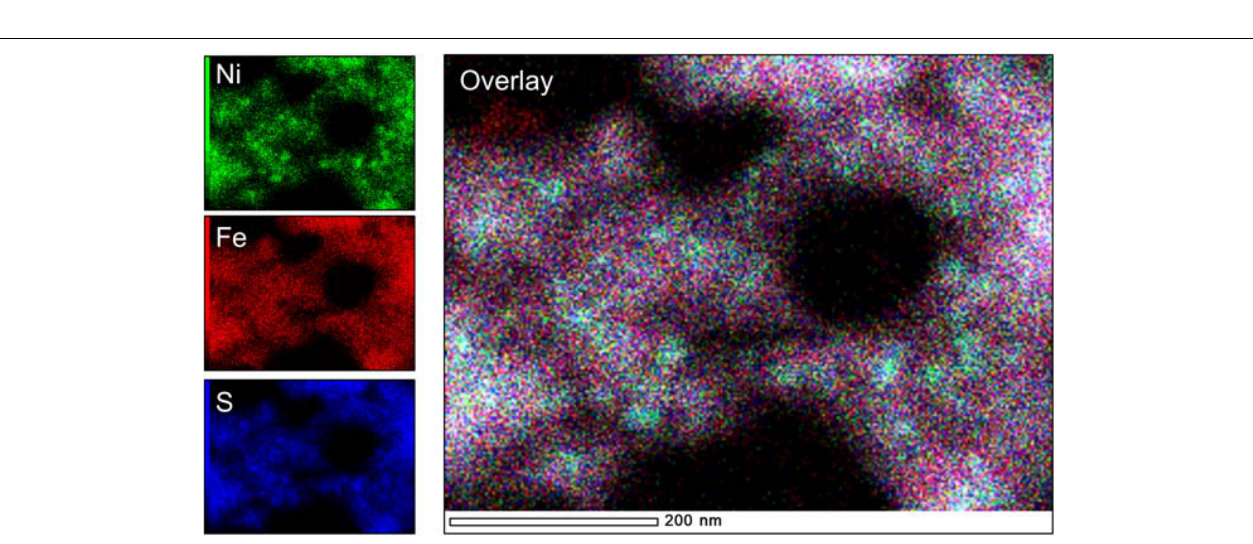
FIGURE 6 | Elemental maps of “Biotic 1:1 Ni:Fe” sample, highlighting the presence of Ni-rich spheroids (teal-colored hotspots in the overlay image) within a more diffuse Fe-rich matrix.